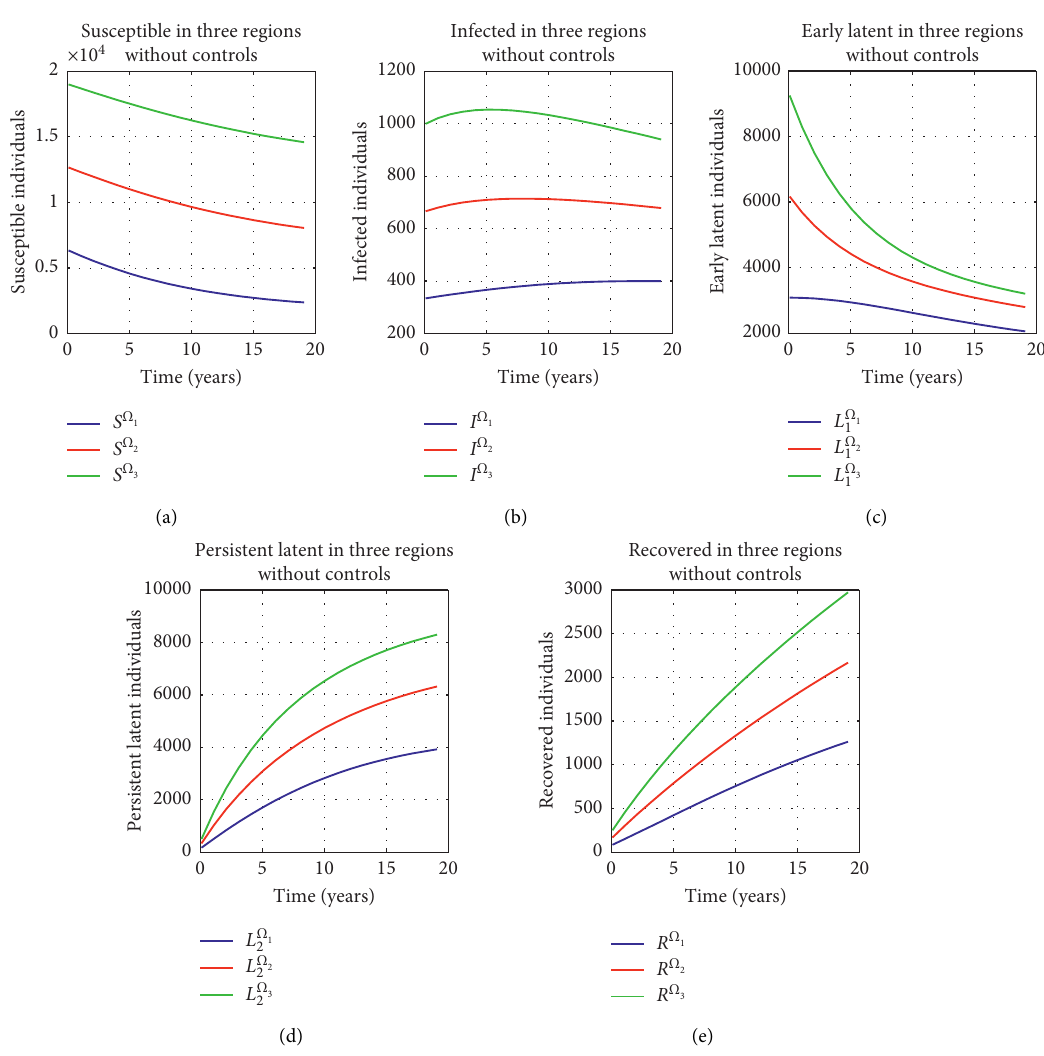
Figure 3: Comparison for each state variable for the three regions without